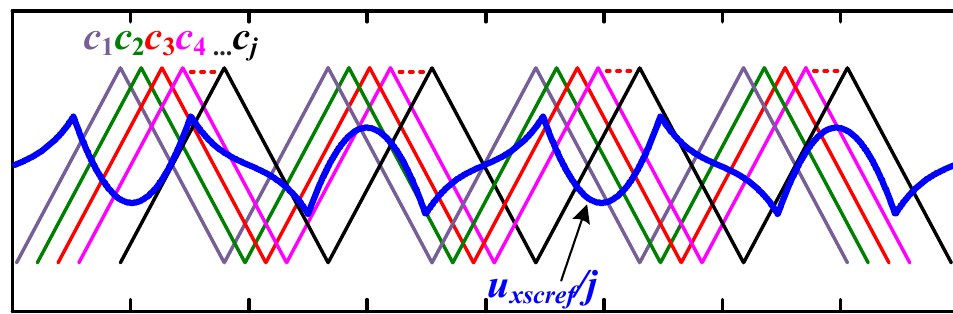
Energies 2022 , 15 , x FOR PEER REVIEW Figure 15. Modulation process of the SCSM stacks. Figure 15. Modulation process of the SCSM stacks.